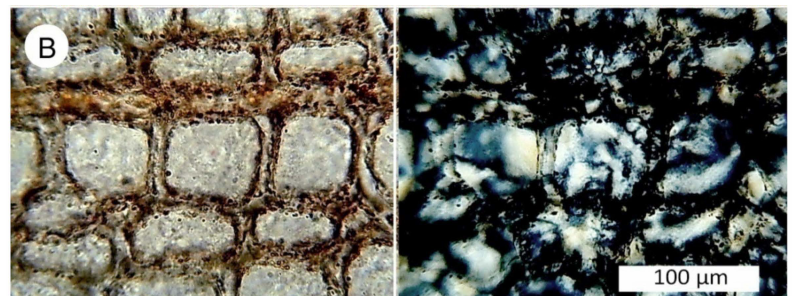
Figure 22. Fossil wood showing dark cell walls that are presumably caused by relict organic matter. transmitted light view on left, polarized light illumination on right. ( A ) Miocene angiosperm wood from Goose Creek, Nevada, USA. ( B ) Cretaceous gymnosperm wood, Phichit, Thailand. Polarized light views show the mineralization. Note that the angiosperm wood features ovoid vessels surrounded by small-diameter cells, in contrast to the rectangular cross-section of tracheid cells in gymnosperm